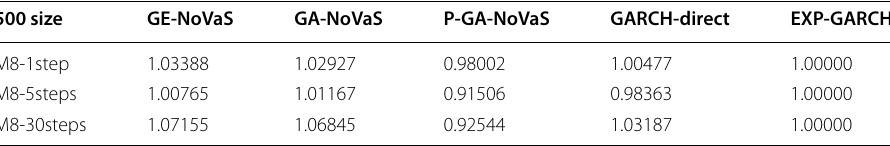
Table 12 Comparison results of NoVaS-type, GARCH(1,1) and Exponential-GARCH(1,1) methods on forecasting 500 size simulated Model 6